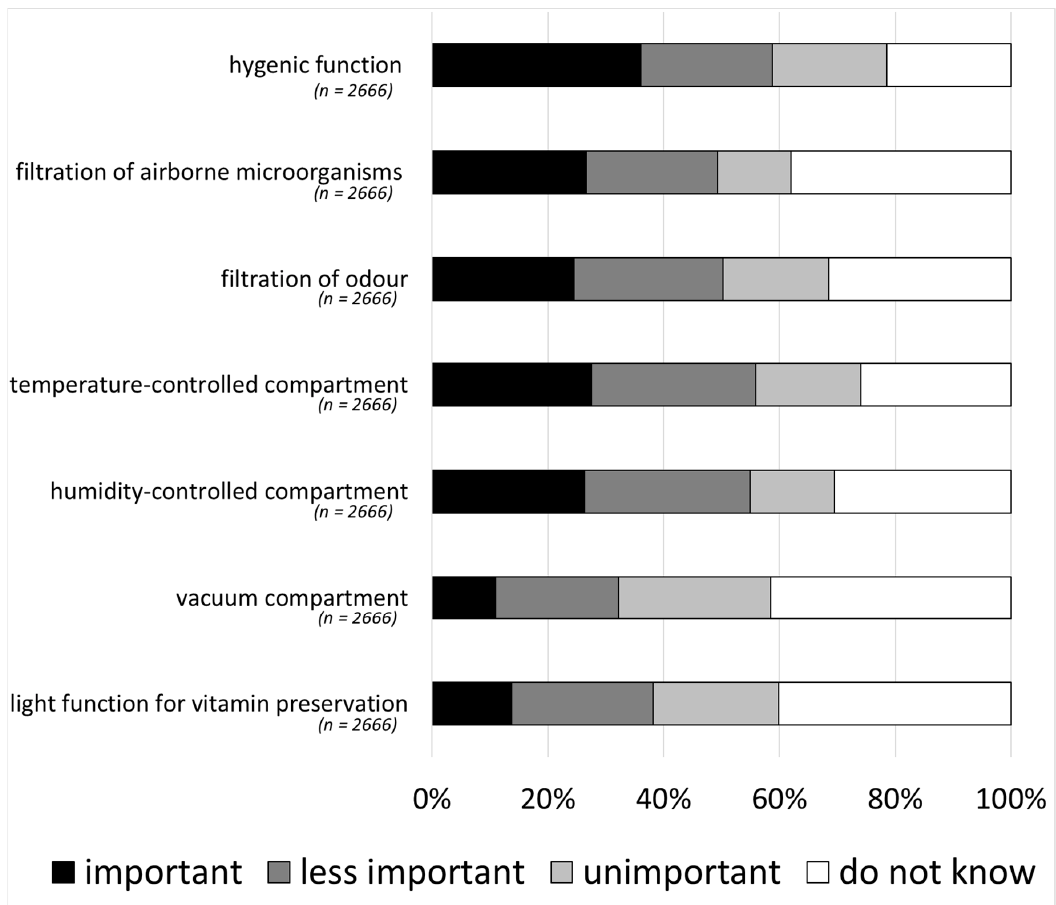
Figure 6. Importance of supplementary storage features (multiple-choice, single-answer).